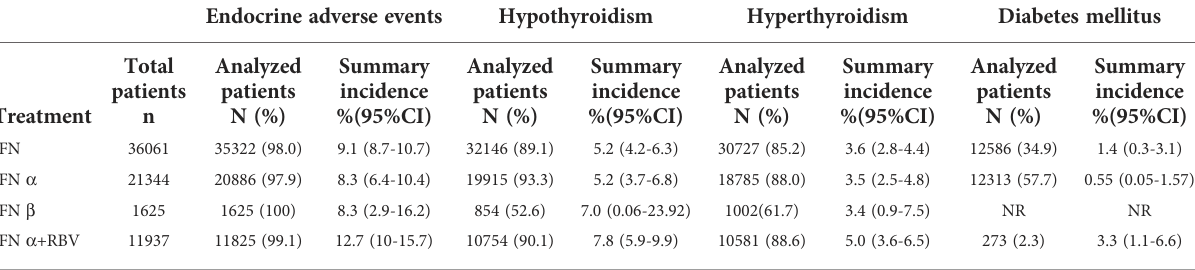
TABLE 1 Summary estimated incidence of endocrine adverse events on